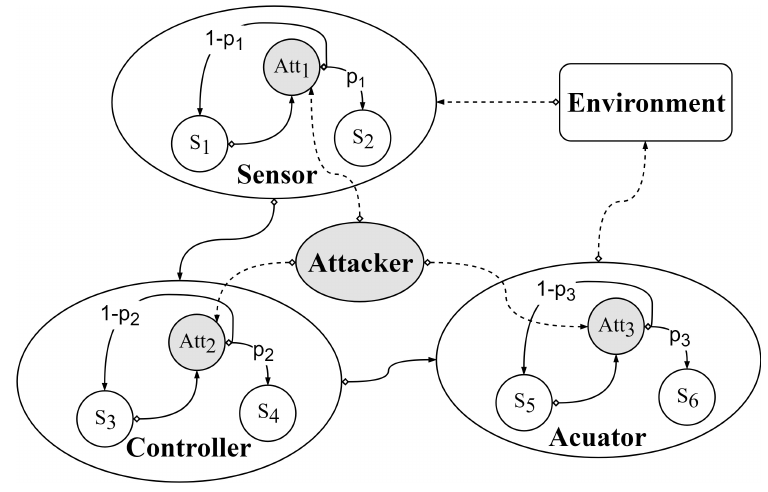
Figure 4. MDP model for security risk